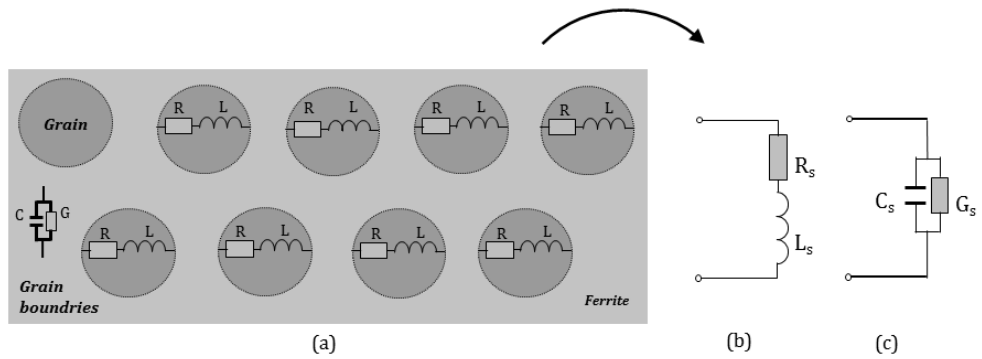
Figure 2. Microstructures of ferrite and the equivalent circuit diagram of the magnetic and electric properties: ( a ) simplified microstructures and schematic of ferrite, ( b ) inductance-resistance model, ( c ) capacitance-resistance model [14,15].